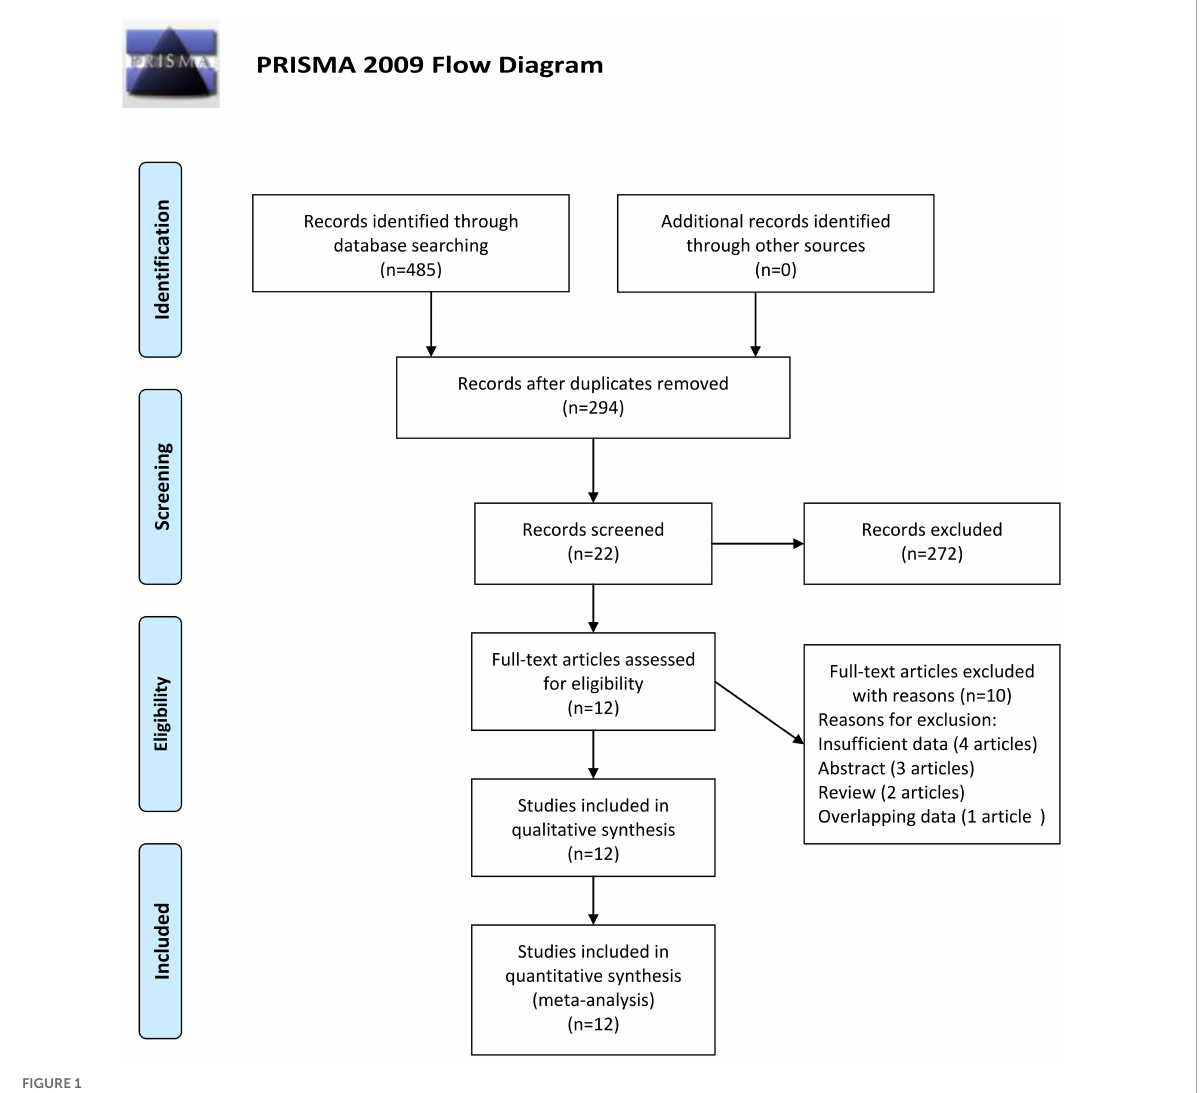
FIGURE1 Flow diagram of study